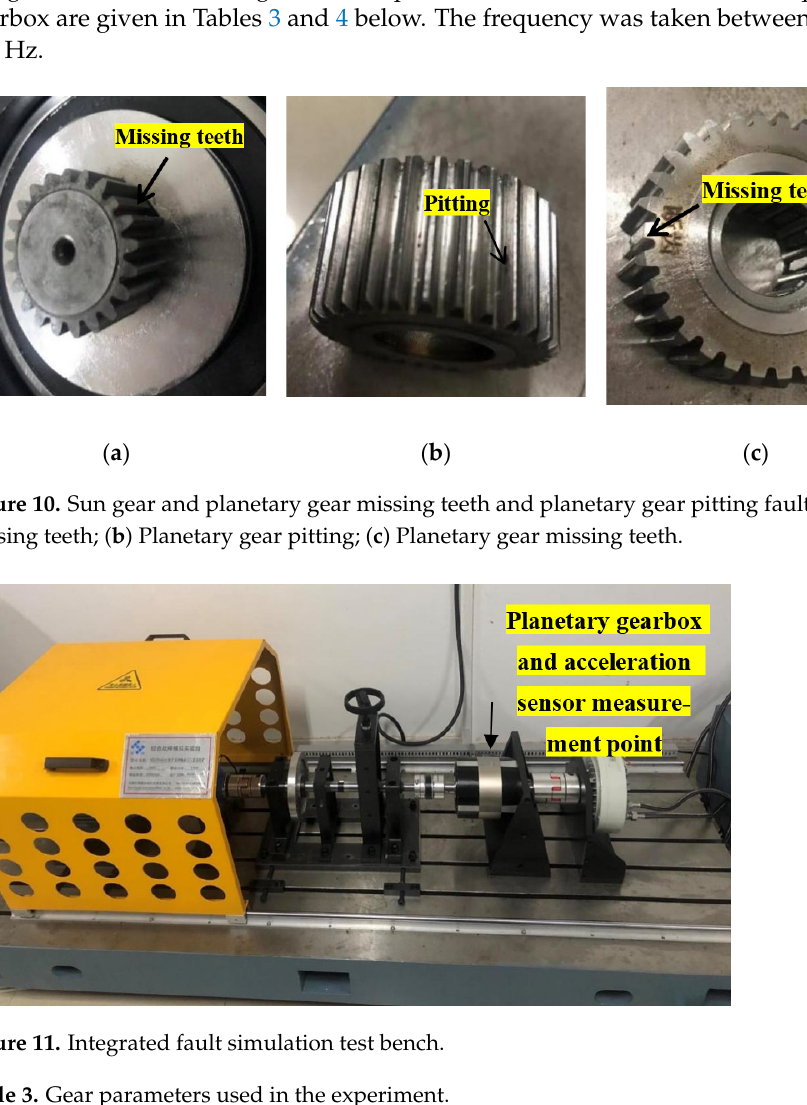
Table 4. Experiment of planetary gearbox characteristic frequency